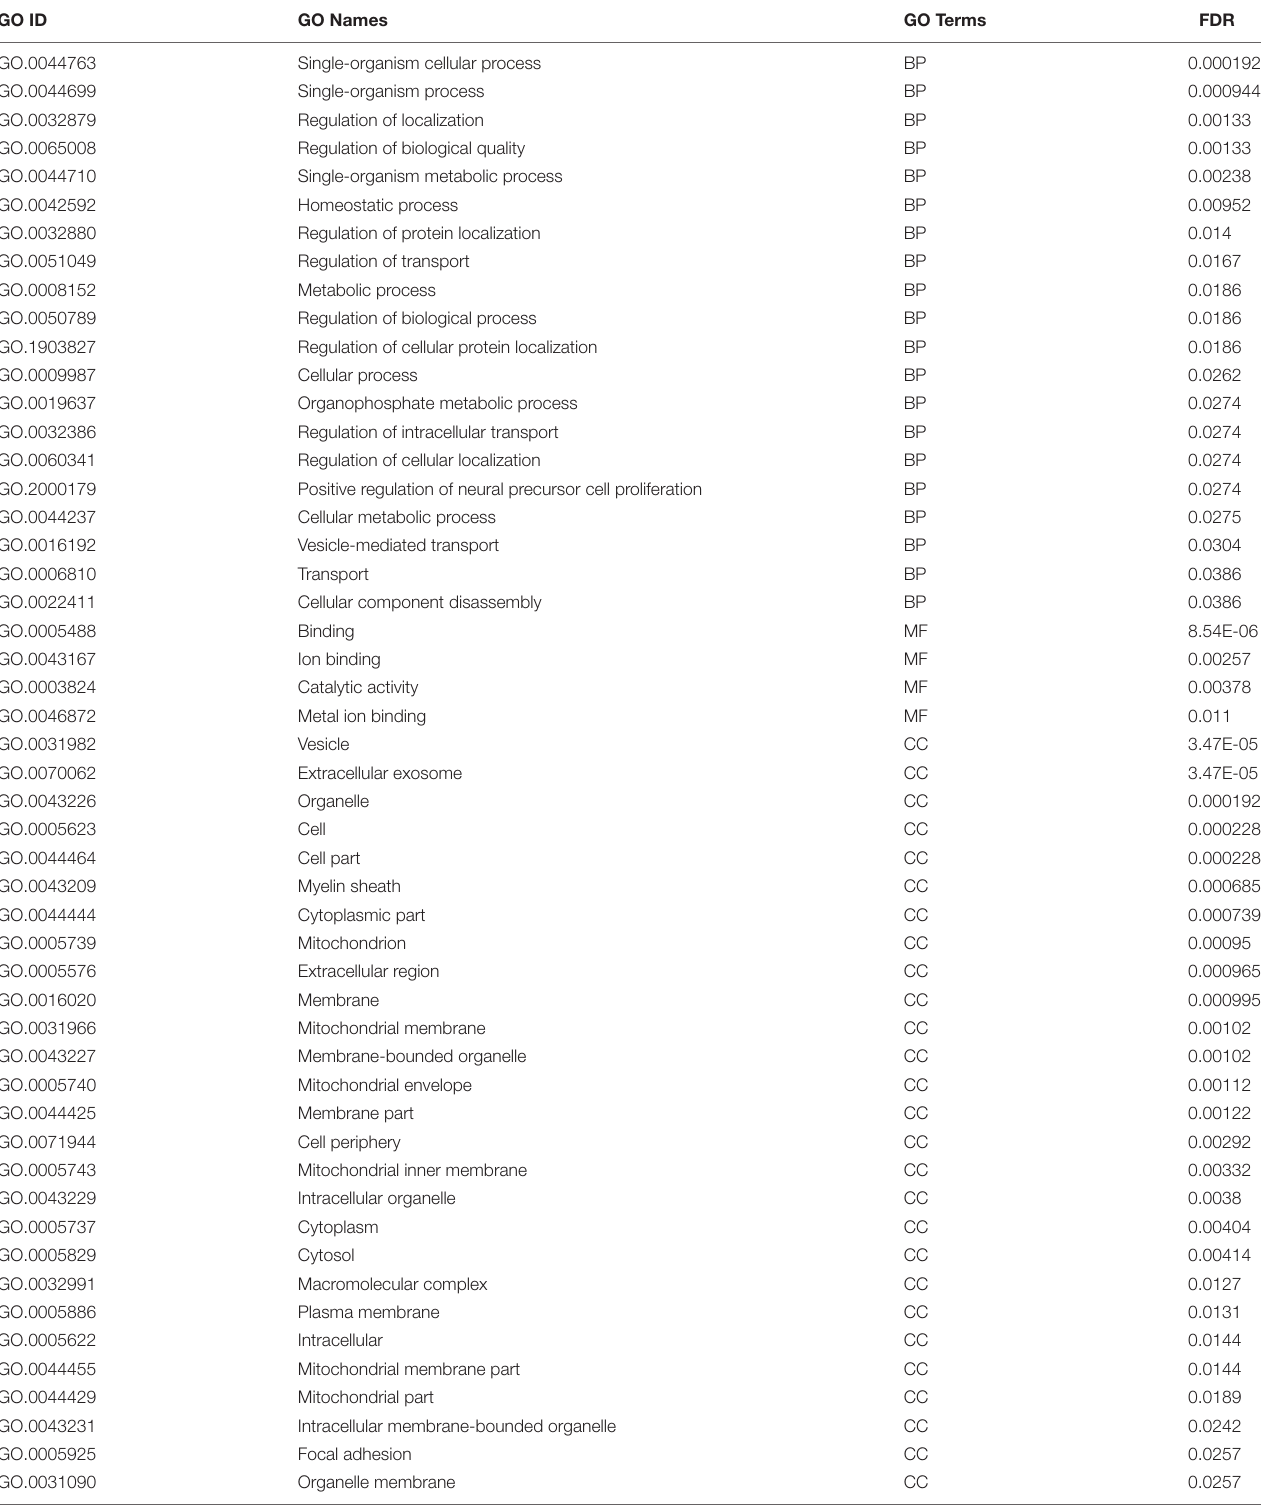
TABLE 3 | The enriched Gene Ontology (GO) terms of differentially expressed genes discovered via meta-analysis between pre- and post-peak milk production. GO ID GO